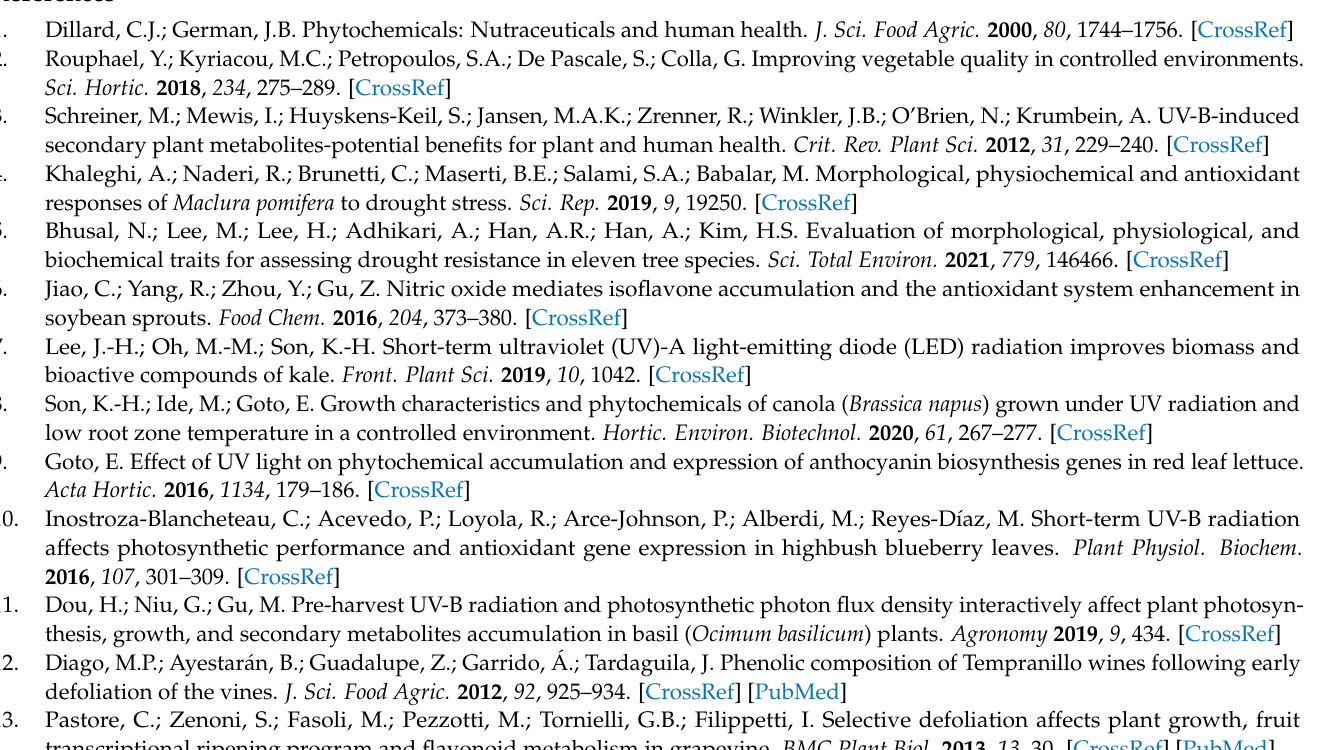
Table S2: Primers of internal standard gene and flavonoid pathway genes used in real-time